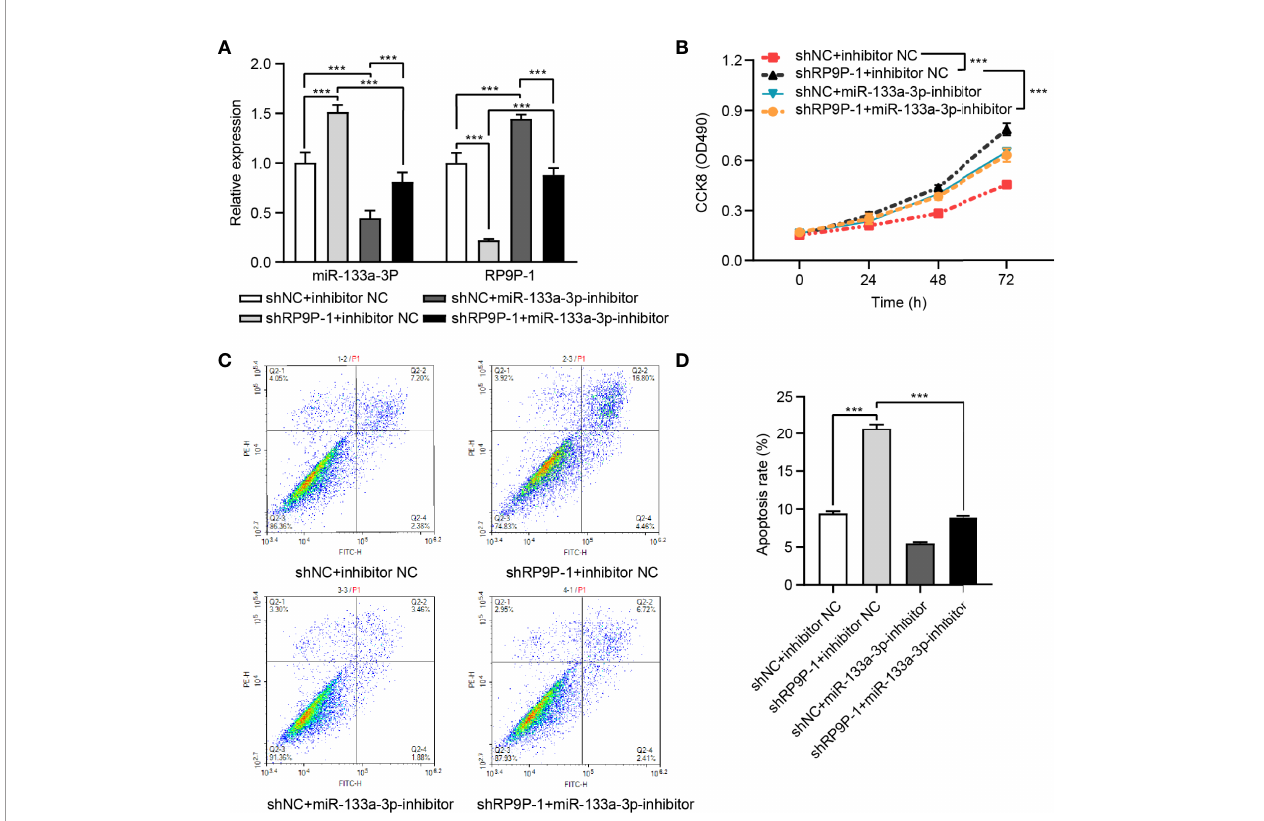
FIGURE 5 | RP9P affects colorectal cancer (CRC) cell viability via miR-133a-3p. (A) RP9P and miR-133a-3p levels in shRP9P-, miR-133a-3p inhibitor-, or nonsense control (NC)- transfected CRC cells. (B) Cell proliferation was measured using the CCK-8 assay. (C, D) Apoptosis after cell transfection was analyzed using fl ow cytometry (C) . The histograms show the average numbers of apoptotic cells (D) (*** p <